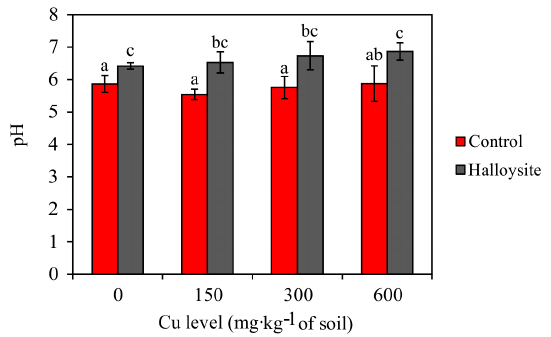
Figure 7. Results of soil pH obtained for the tested amendment; (mean ± SD, n = 3). Values in columns marked with the same letter do not differ significantly (Duncan’s test, p > 0.05).